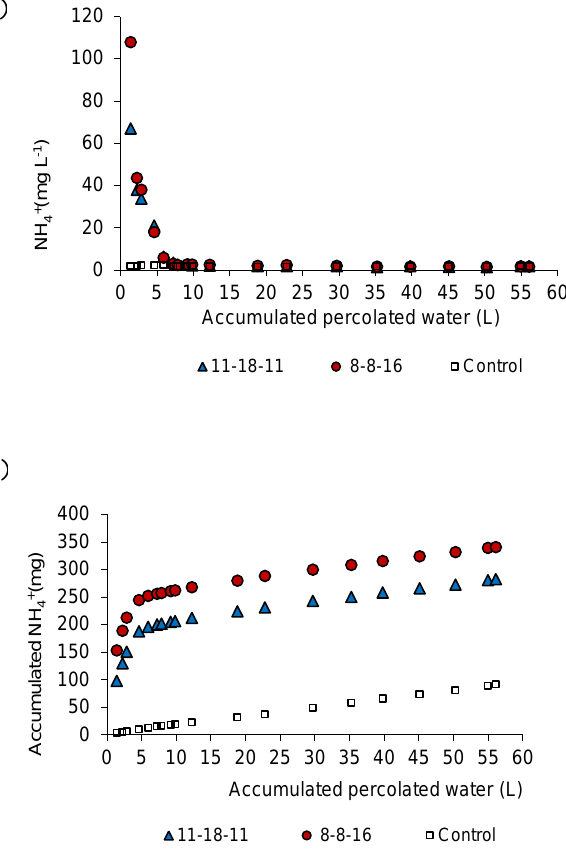
Figure 3. Ammonium concentrations in leachates (a) and accumulated NH 4+ losses (b) from fertilized and control columns along the experiment (average of three replicates). 5